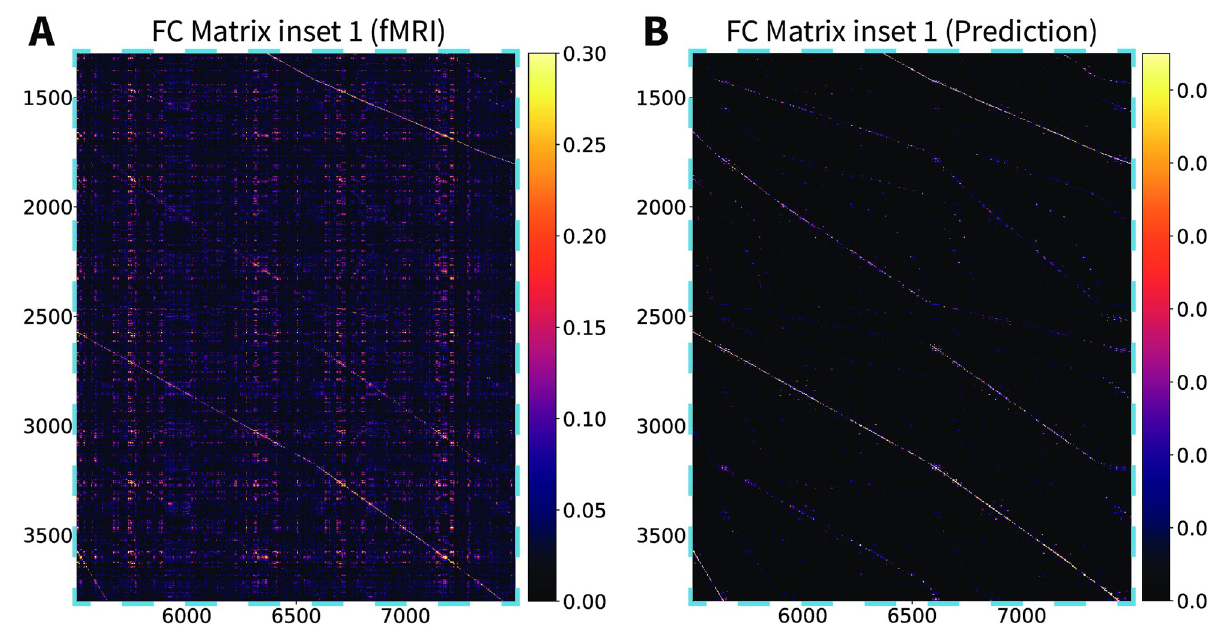
Fig 8. Stochastic Wilson-Cowan graph neural field model predicts the experimental functional connectivity matrix (inset 1). (A) An inset of the vertex-wise, resting-state fMRI functional connectivity matrix for a single subject. (B) The same inset for the Wilson-Cowan graph neural field model with the parameters of S2 Table.